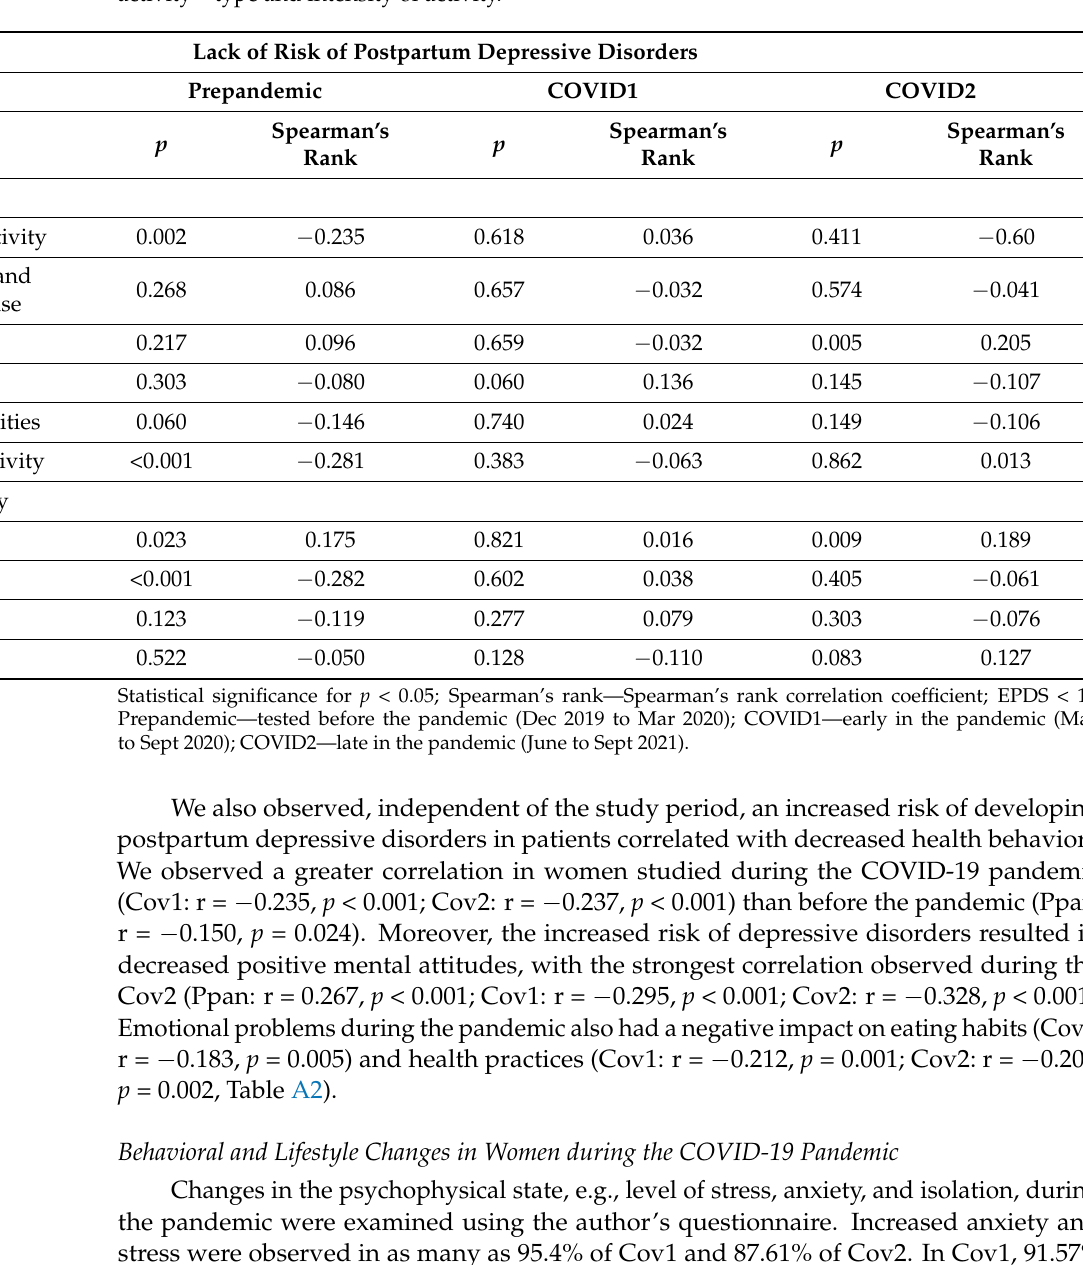
Table A1. Spearman’s Rank Correlations between low risk of depressive disorders and physical activity—type and intensity of